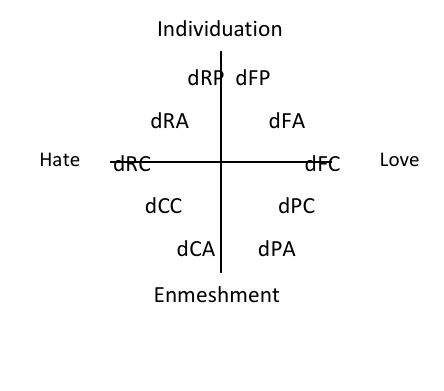
Figure 5: The 12 Developmental Ego States of the Integrated Self